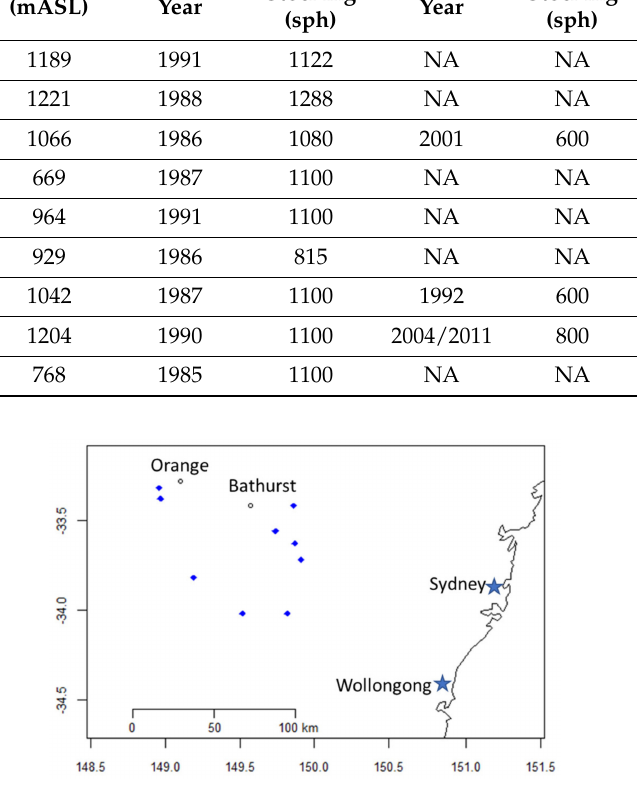
Figure 1. Locations of the nine sample sites in northern NSW,